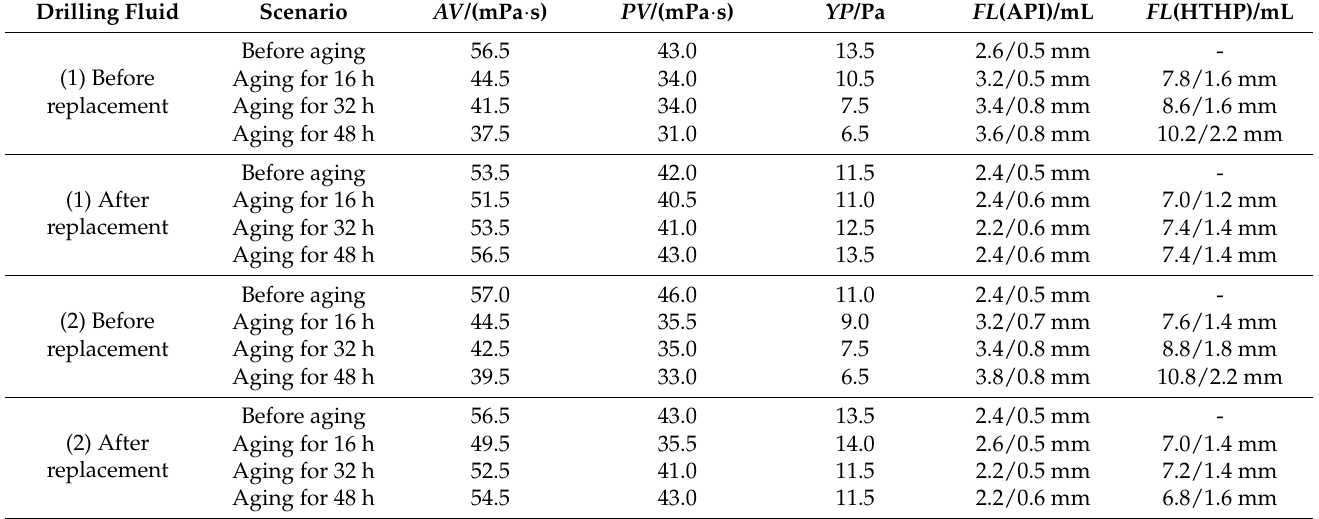
Table 2. Performance tests of drilling fluids before and after